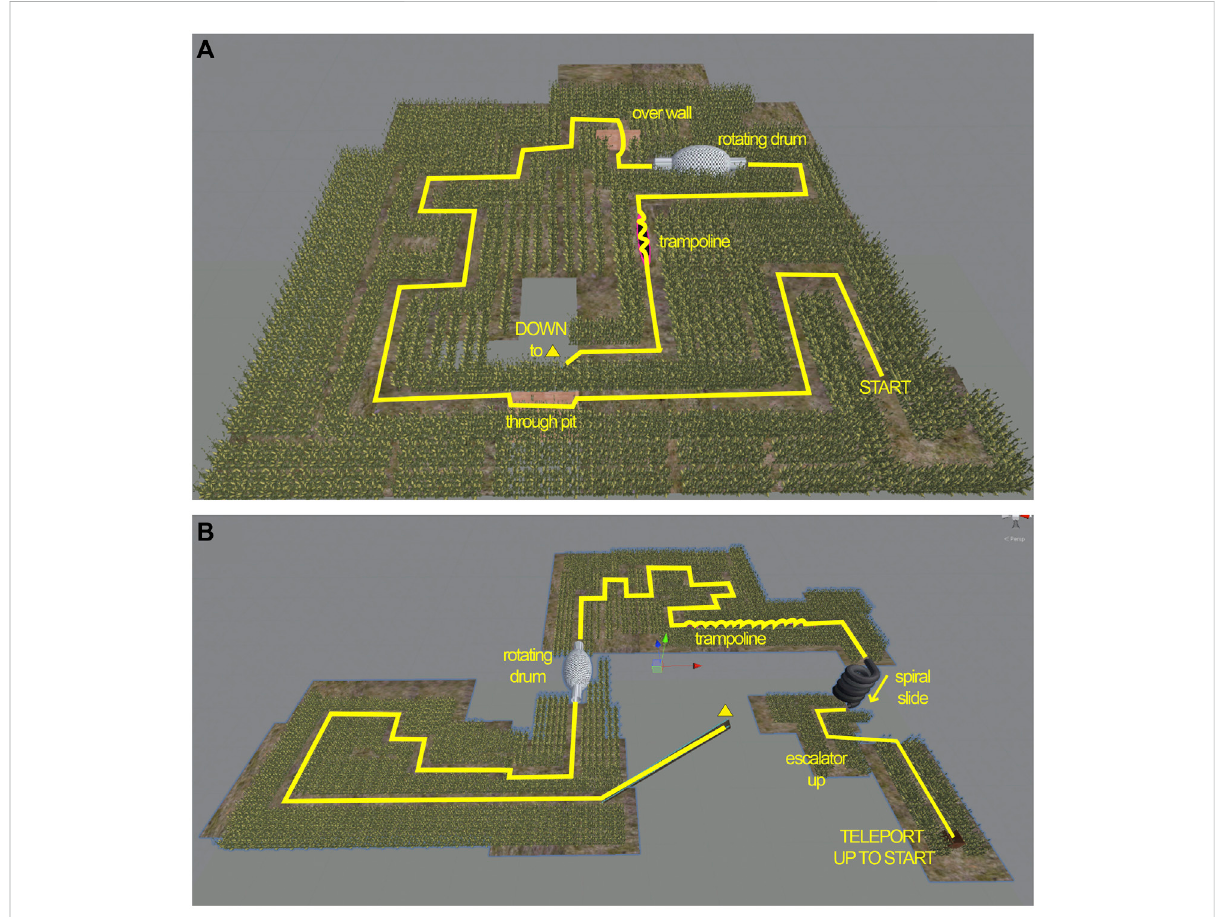
FIGURE 1 TopportionoftheCybersicknessCornMaze (A) andbottomportionofthemaze (B) .Participantsbeganinthebottomrightofthetopportionat START and progressed through the maze until reaching DOWN to ▽ , where they descended to the lower portion via the diagonal ramp. Participants travelled through the bottom portion of the maze until they experienced a dark grey spiral slide that put them brie fl y on a small even lower level, before ascending on an escalator ramp to the brown box, which then teleported them back to